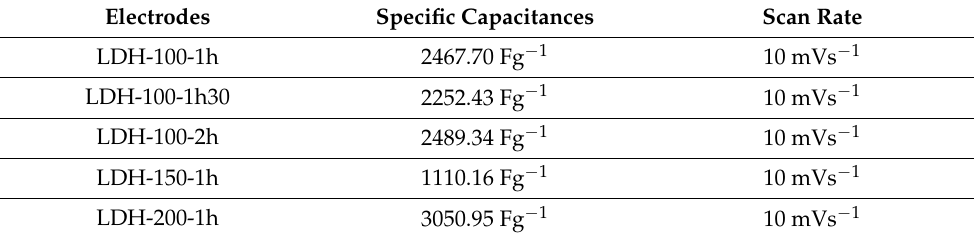
Table 2. Specific capacitances calculated from the CV curves at the scan rate of 10 mVs − 1 .